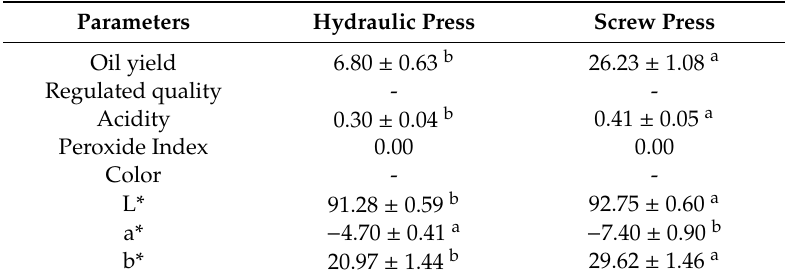
Table 2. Oil yield, parameters of regulated quality, and color of melon-seed oils (cv. Piel de Sapo PGI) according to extraction